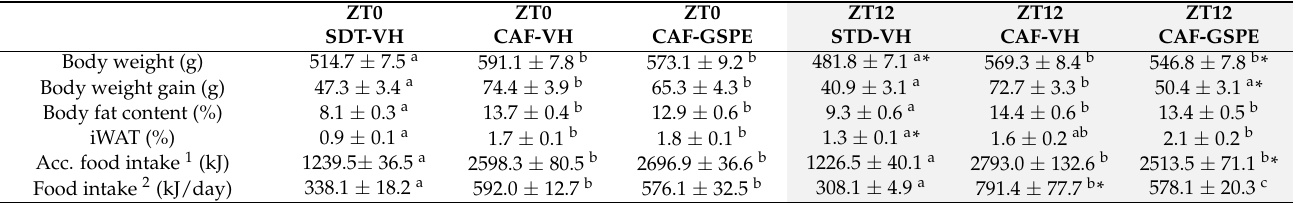
Table 1. Biometric parameters of rats fed standard or cafeteria diet supplemented with vehicle or GSPE at ZT0 or ZT12 during the last 4 weeks of the